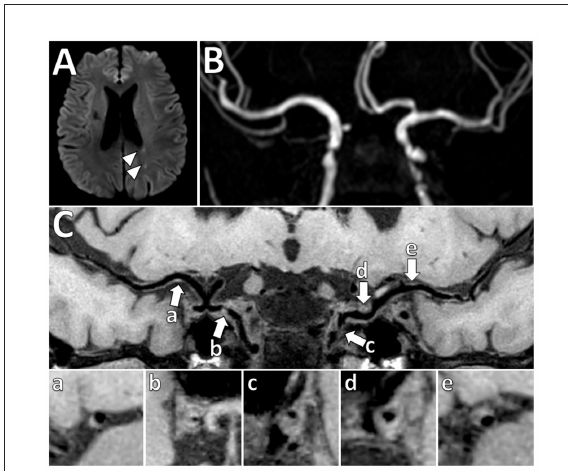
FIGURE5 Vessel wall thickening and atherosclerosis on VW-MRI in a symptomatic patient. (A) A patient with left parietal lobe acute ischemic infarcts (arrowheads) underwent intracranial VW-MRI. (B) Time-of-flight MRA and (C) intracranial VW-MRI shows multiple intracranial plaques (arrows) that showed both eccentric (a, b, c, e) and concentric (d) vessel wall thickening. The culprit lesion was thought to be the most stenotic lesion (c) in the left internal carotid artery.